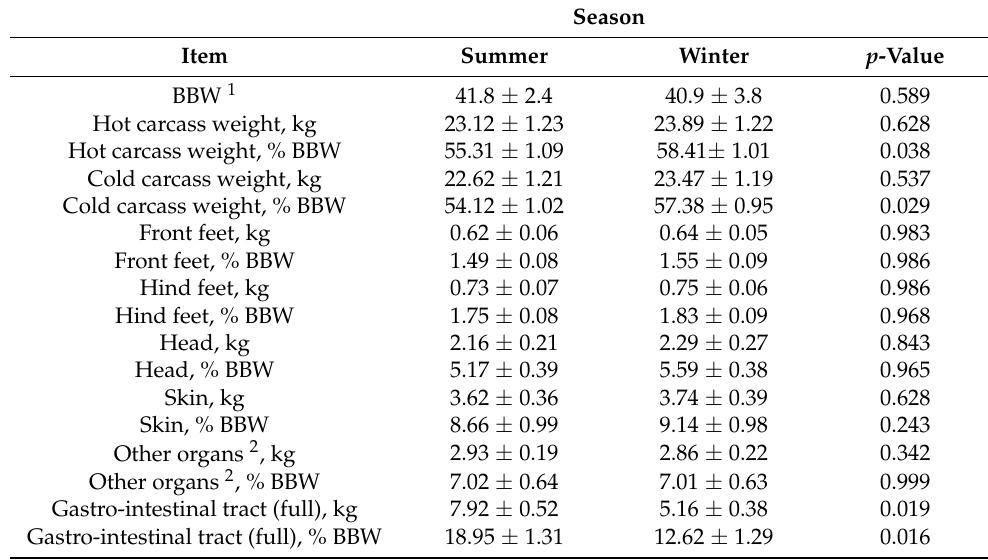
Table 1. Seasonal variation in the slaughter value of the fallow deer (LSM ±